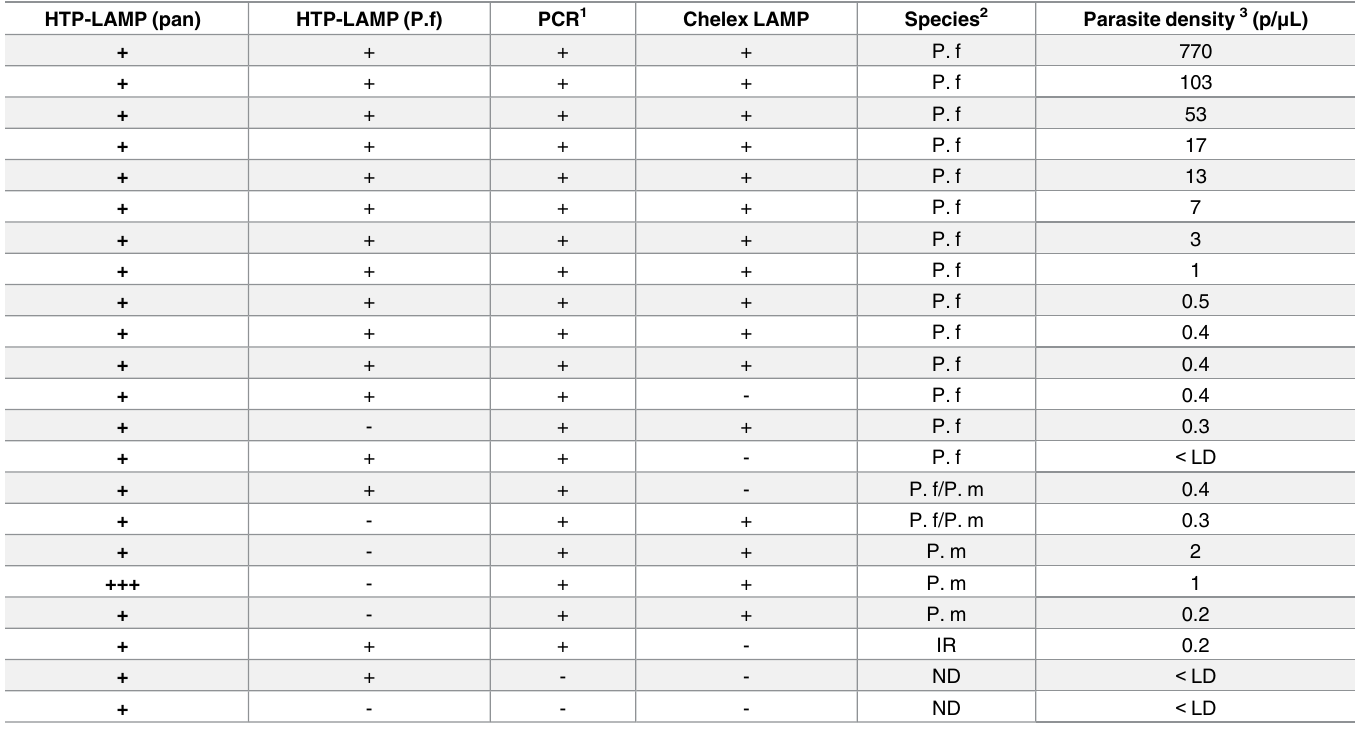
Table 1. Characterization of HTP-LAMP positive blood samples (N =